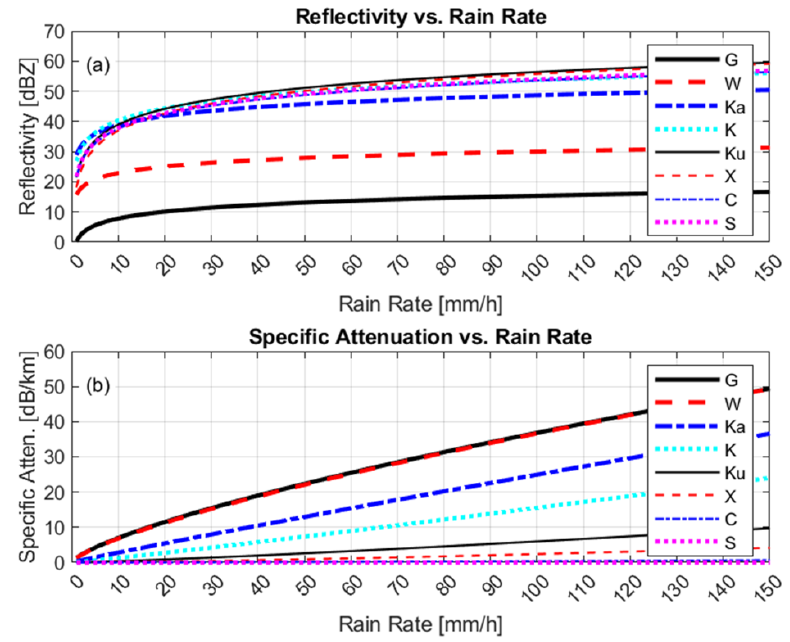
Figure 5. Relationships between surface Parsivel disdrometer derived rain rate, radar effective re- flectivity factor, and rain specific attenuation. ( a ) Radar Ka-band effective reflectivity factor [dBZ] versus rain rate [mm h −1 ] with colors indicating 𝐷 𝑚 [mm]. ( b ) Radar Ka-band rain specific attenua- tion [dB km −1 ] versus rain rate [mm h −1 ] with colors indicating 𝐷 𝑚 [mm]. The regression lines are power-law fits of the form (6) and (7) with coefficients listed in Table 3.